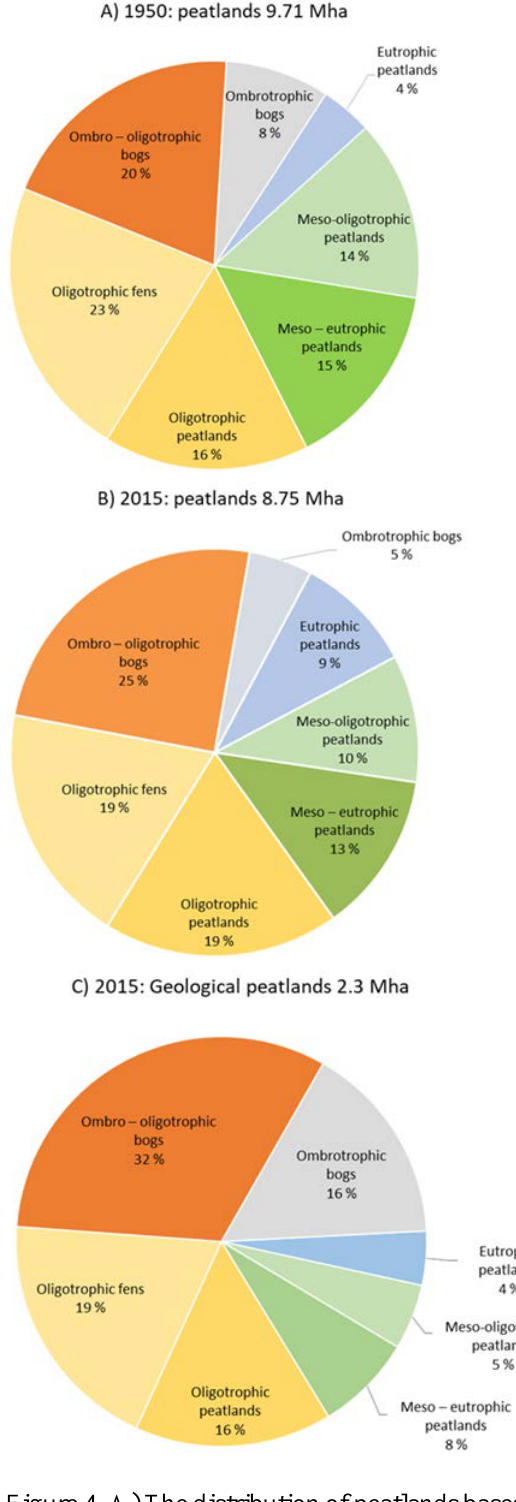
Figure 4. A) The distribution of peatlands based